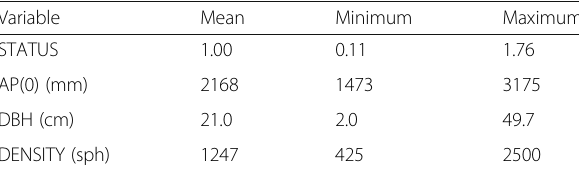
Table 1 Summary information for the significant predictor variables (STATUS and AP(0)) in the final fitted model